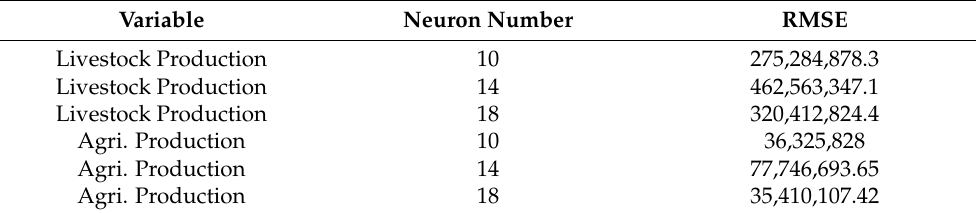
Table 2. RMSE results for MLP models with different numbers of neurons in the training phase.